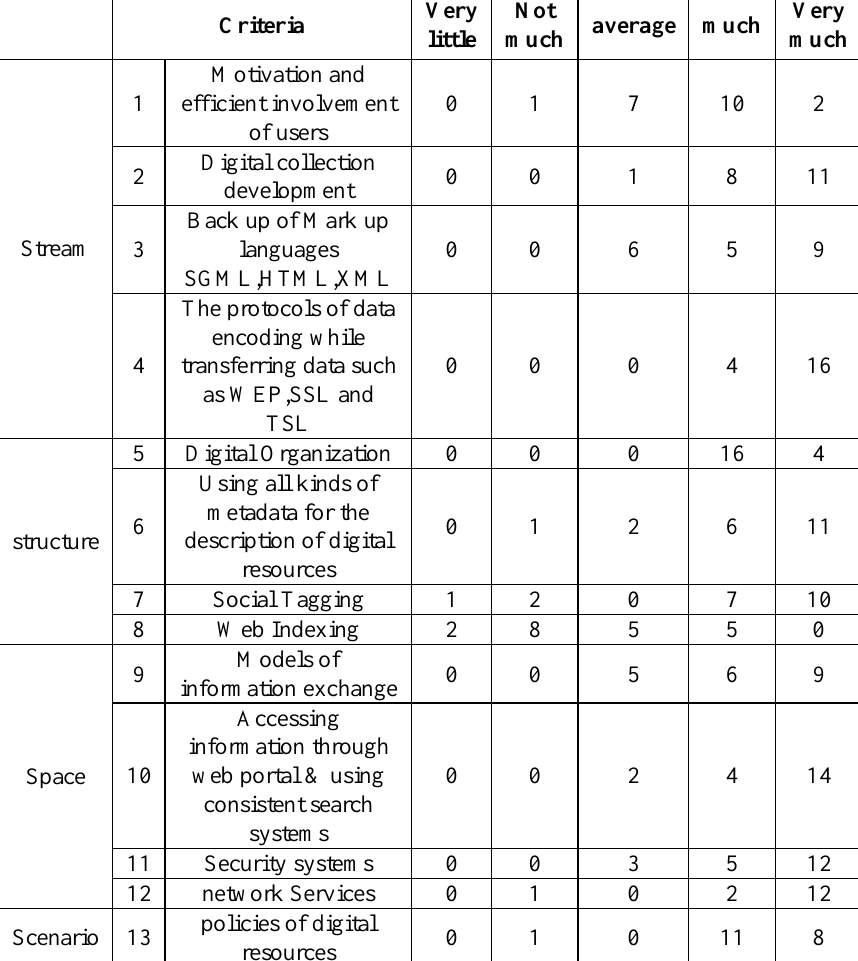
Table 2.Results of counting the answers of the poll's first